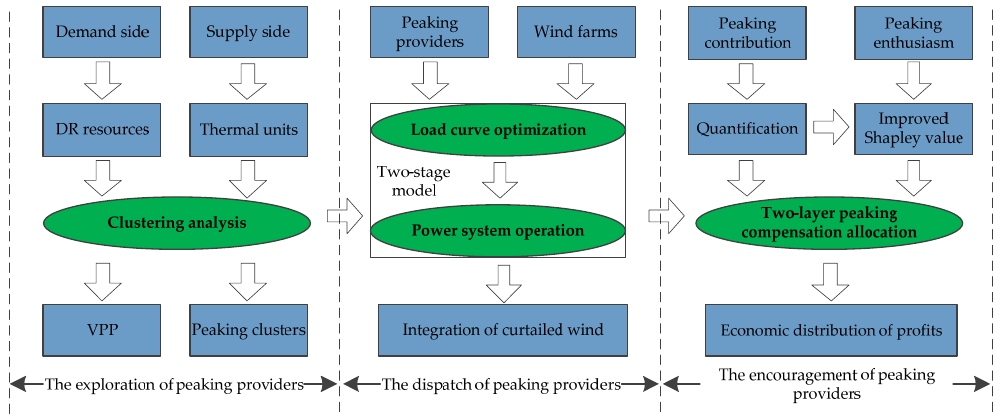
Figure 3. Compensation mechanism model.